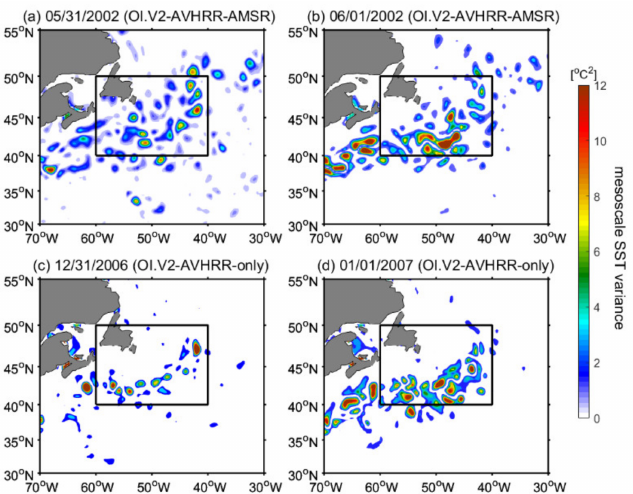
Figure 4. The snapshots of mesoscale SST variance in the GSE region based on the ( a , b ) OI.V2- AVHRR-AMSR data on ( a ) 31 May 2002 and ( b ) 1 June 2002; ( c , d ) OI.v2-AVHRR-only data on ( c ) 31 December 2006 and ( d ) 1 January